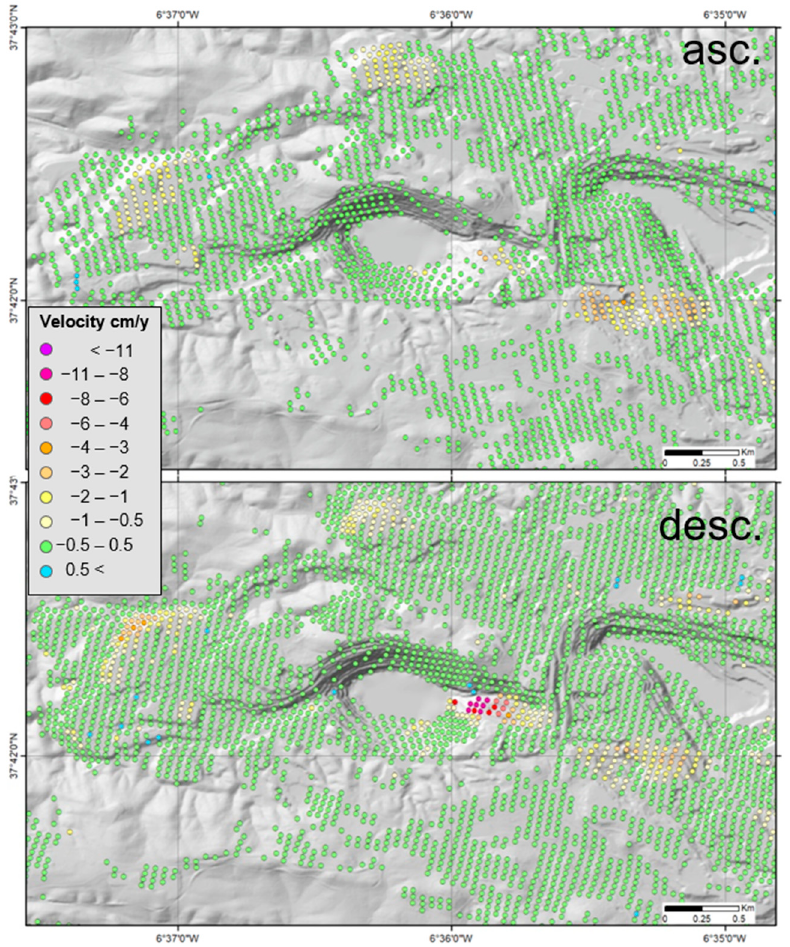
Figure 5. Map of displacement measured in LOS. Negative values mean moving away from the satellite. Ascending geometry up, descending geometry down.